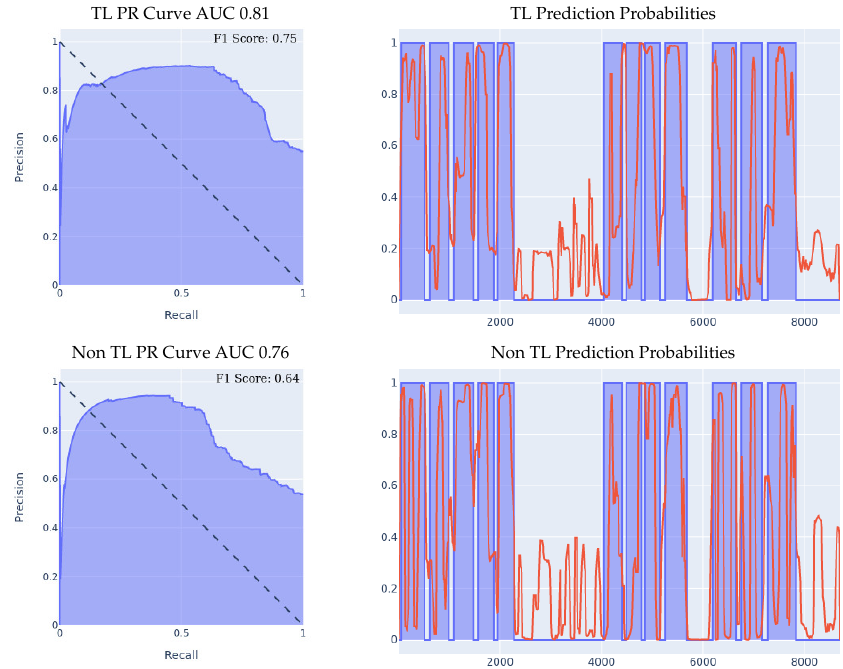
Figure 10. Leave-one-person-out data split experiment for MSBAND to Huawei. The averaged F1 score of all 11 iterations of the cross-validation is shown in the top right corner of the PR curve.